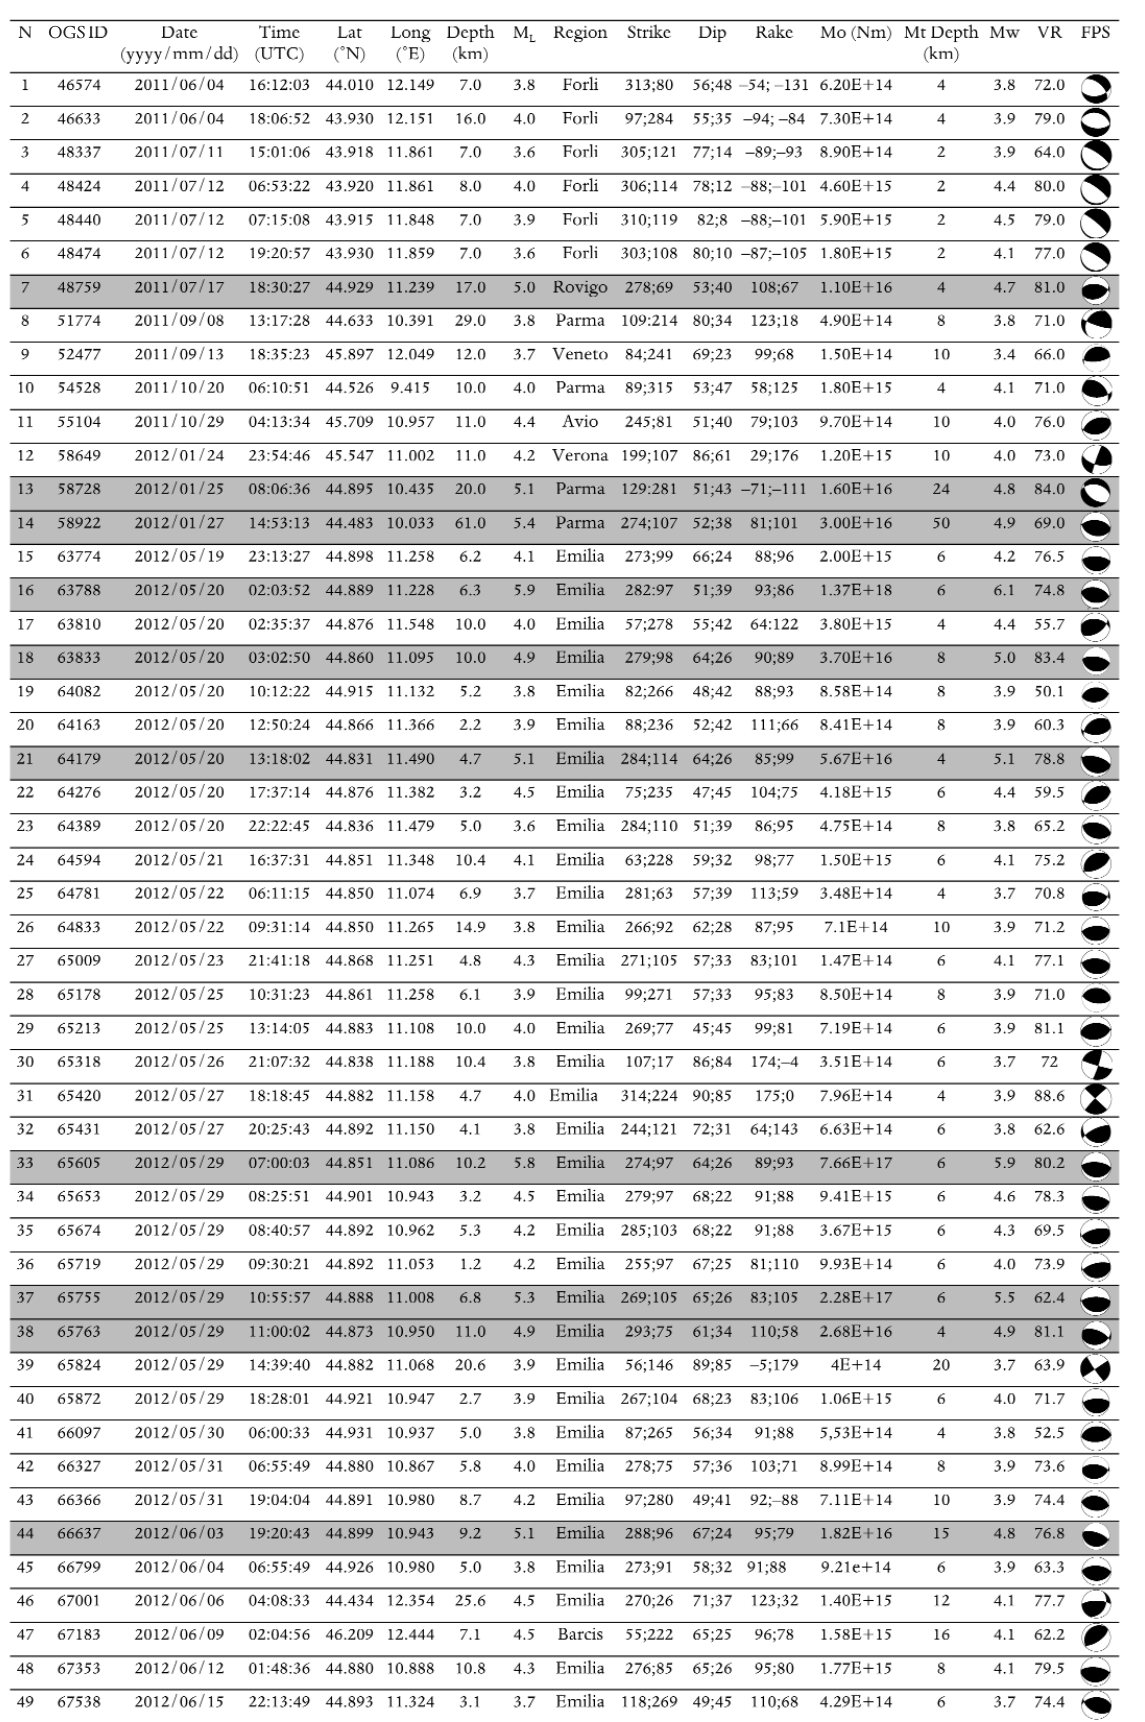
Table 1. Dataset of the focal mechanisms released for this study. Gray highlighted events are used as source faults for the Coulomb stress analysis. Loca- tions are taken from ISIDe, except for event Nos. 7, 9, 11 and 47, which are taken from OGS bulletins. Mo, seismic moment; Mt, moment tensor; VR, vari- ance reduction; FPS, fault plane